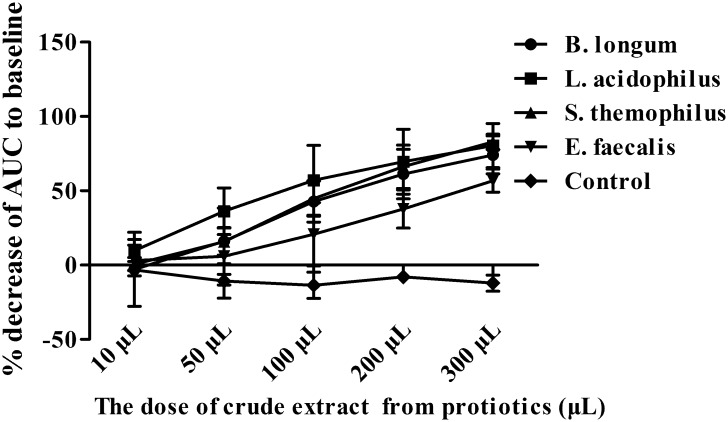
Crude extracts inhibited human colonic smooth muscle contraction in a dose-dependent manner.% inhibition of AUC increased with the increased concentration of crude extracts (all P<0.05). The inhibition effect of the crude extracts from E.faecalis was the weakest compared with others at 100μL, 200μL and 300μL dose (all p<0.05). N = 6 for each group.